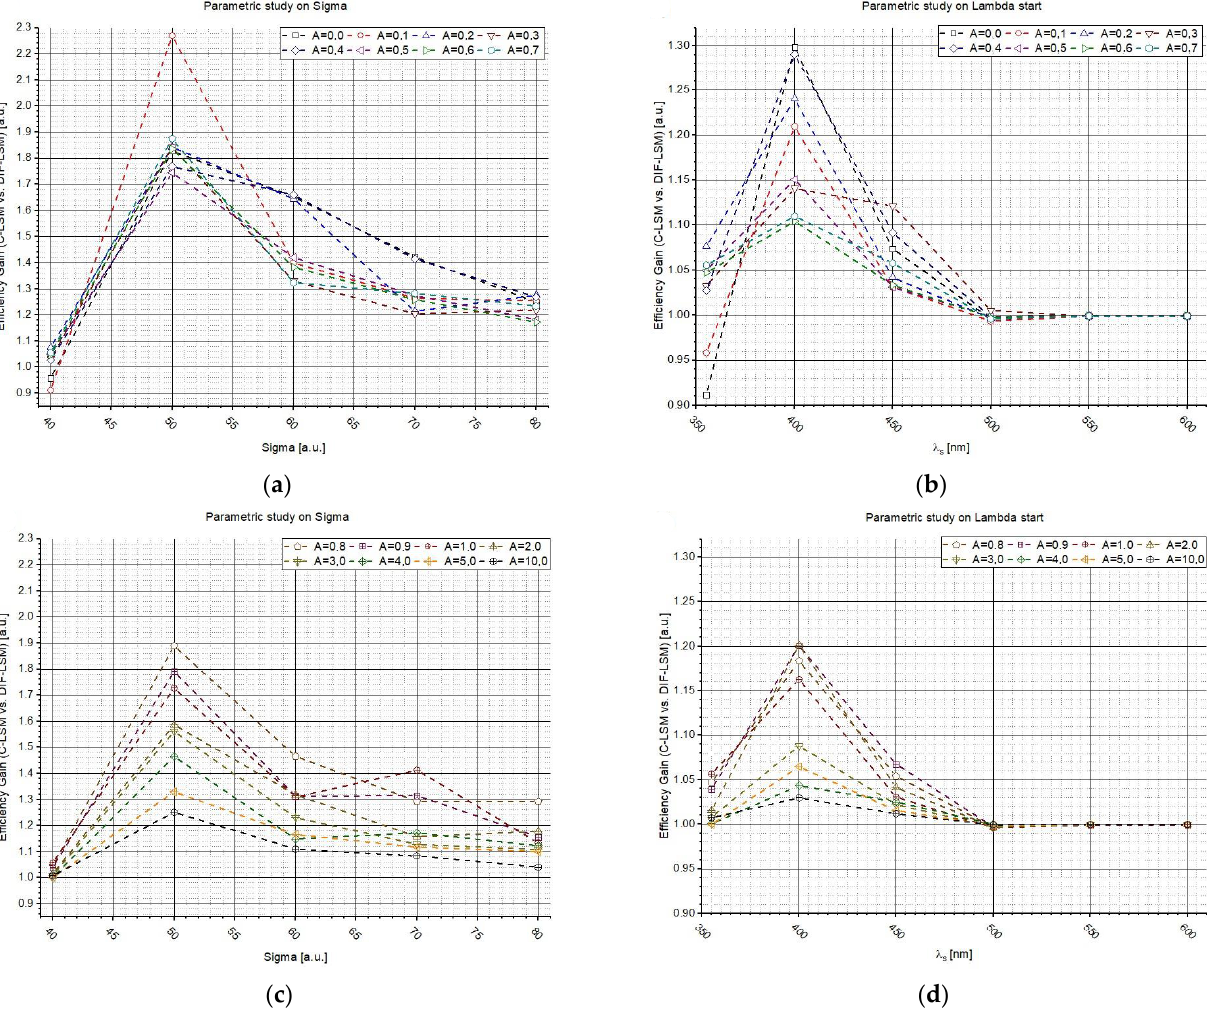
Figure 3. Influence of the spectrum shapes and A on W DIF -LSM varying σ ( a – c ) and 𝜆 𝑠 ( b – d ) of spectrum 2.